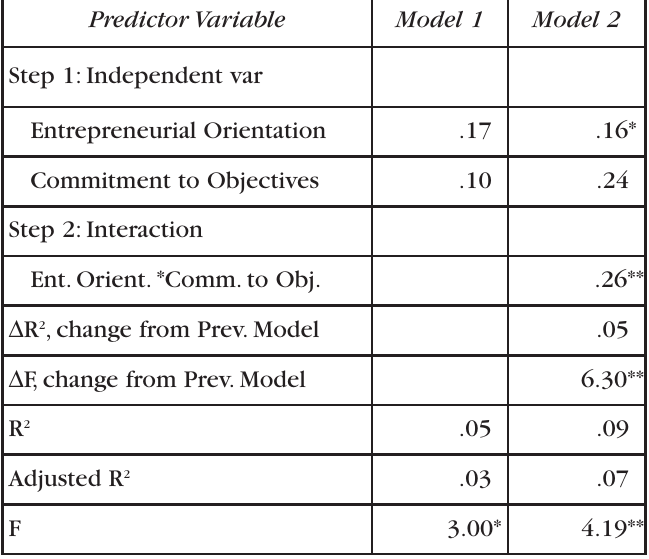
Table 2. Results of Hierarchical Regression